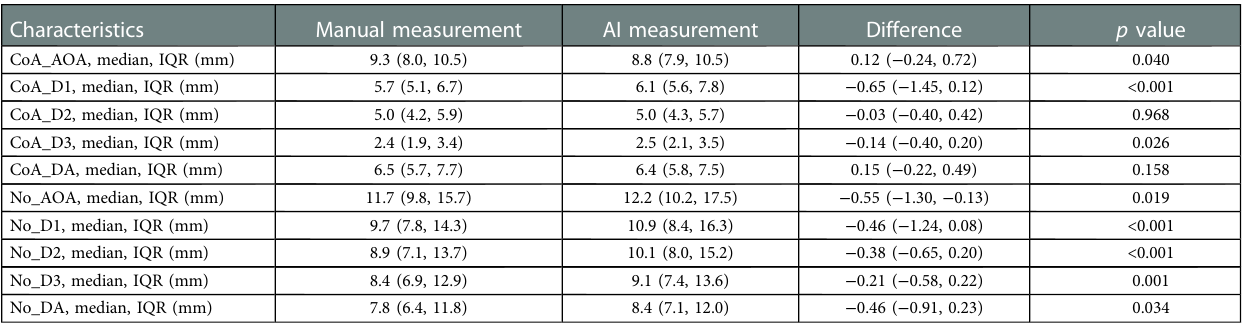
TABLE 1 Measurement results of two measurement